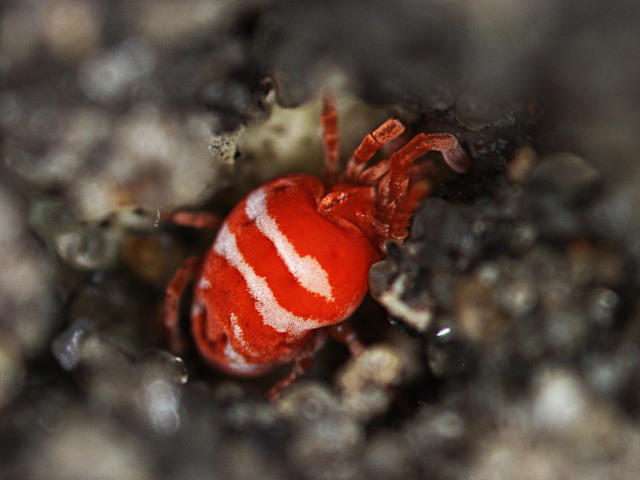
Platytrombidium
fasciatum. Photo Magdalena Felska.